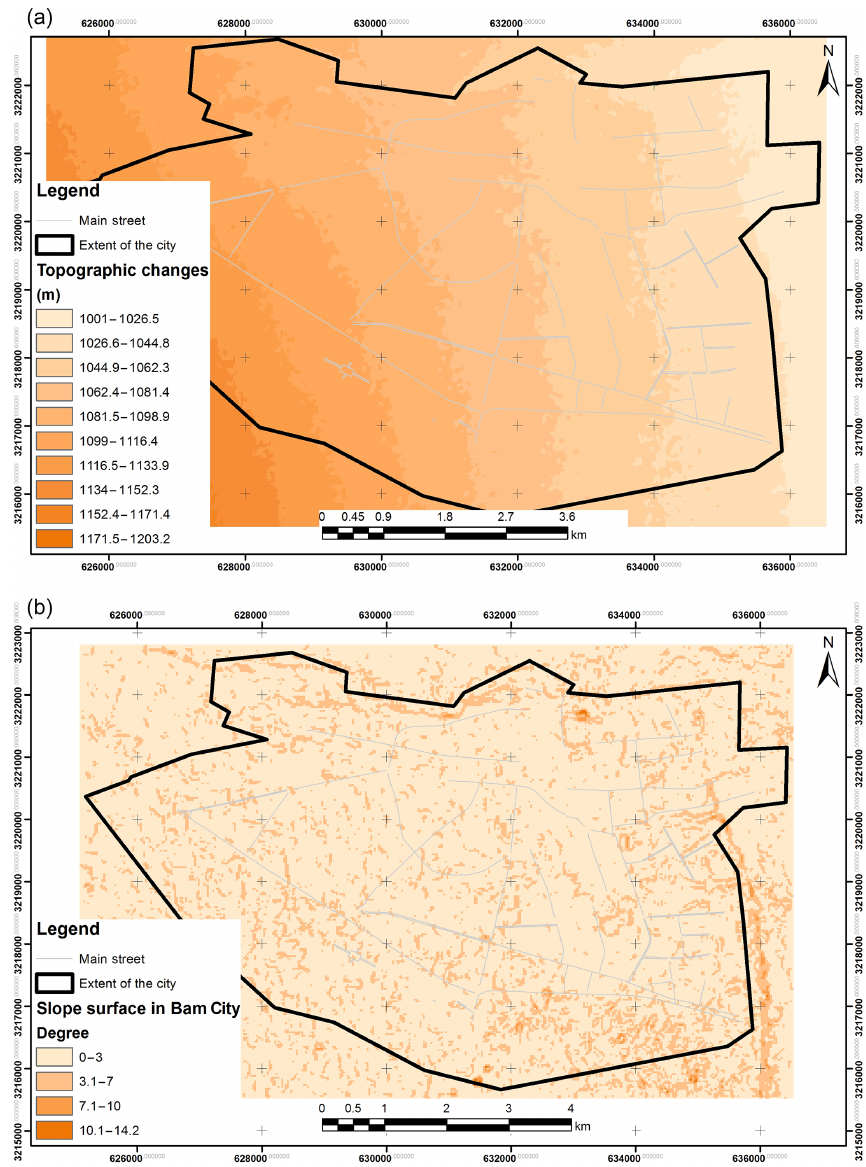
Figure 9. Thematic layers of Bam City: topographic irregularities (a) and slope (b)